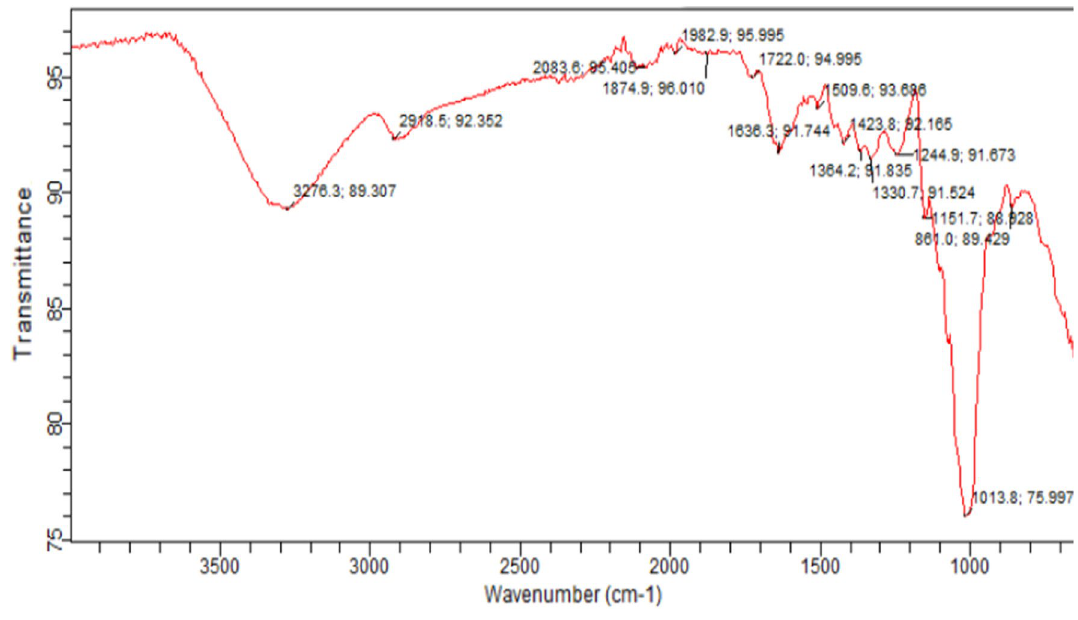
Fig. 2 Fourier transform infrared spectrum of the CS adsorbent